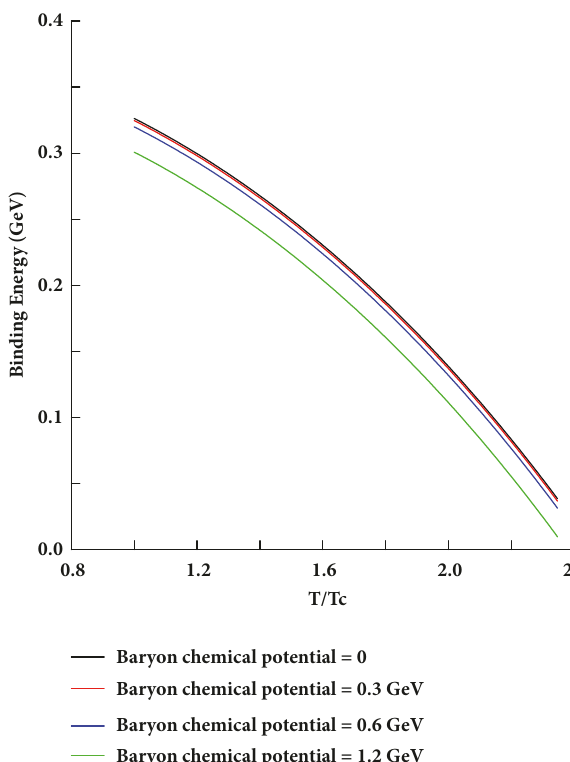
Figure 4: The binding energy of 1S charmonium is plotted as a function of temperature at 𝜉 = 0 and parameter and 𝑁 = 3 for different values of baryonic chemical